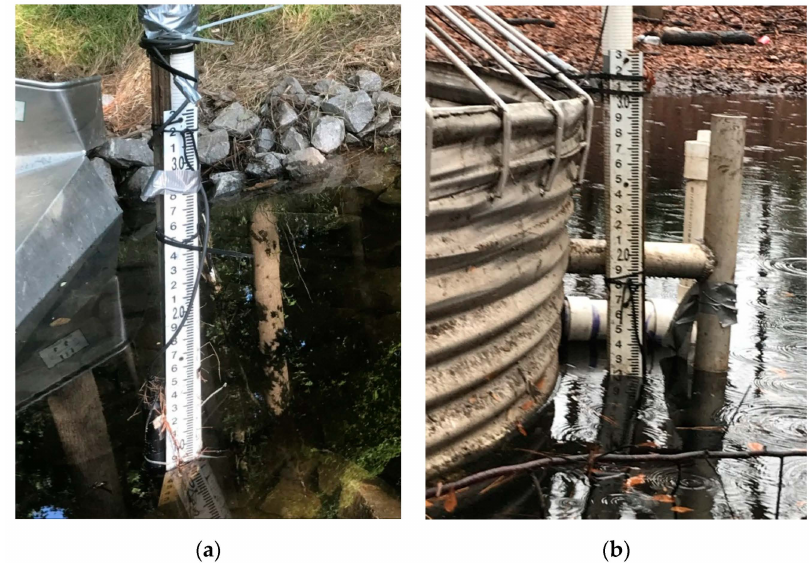
Figure 4. Stilling well with stage plate installed near the inlet of the wetland ( a ). Stilling well with stage plate installed near outlet pipes of wetland ( b ). Photographs were captured by the